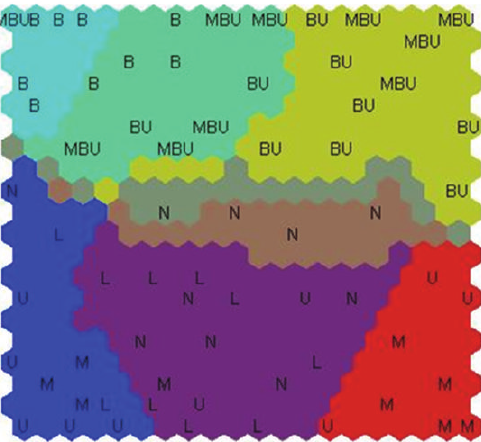
Figure 20: SOM test for RMS